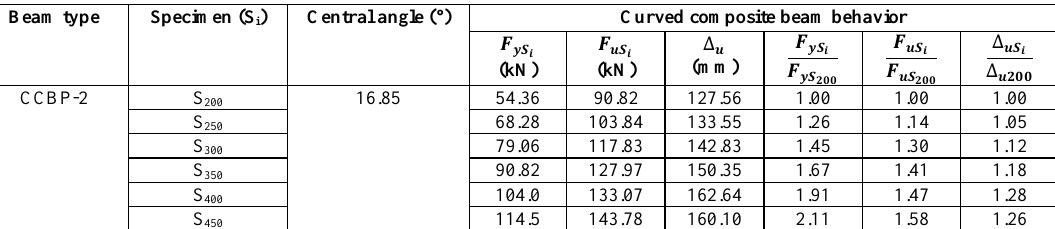
Table 9. Effect of the yield stress on the curved composite